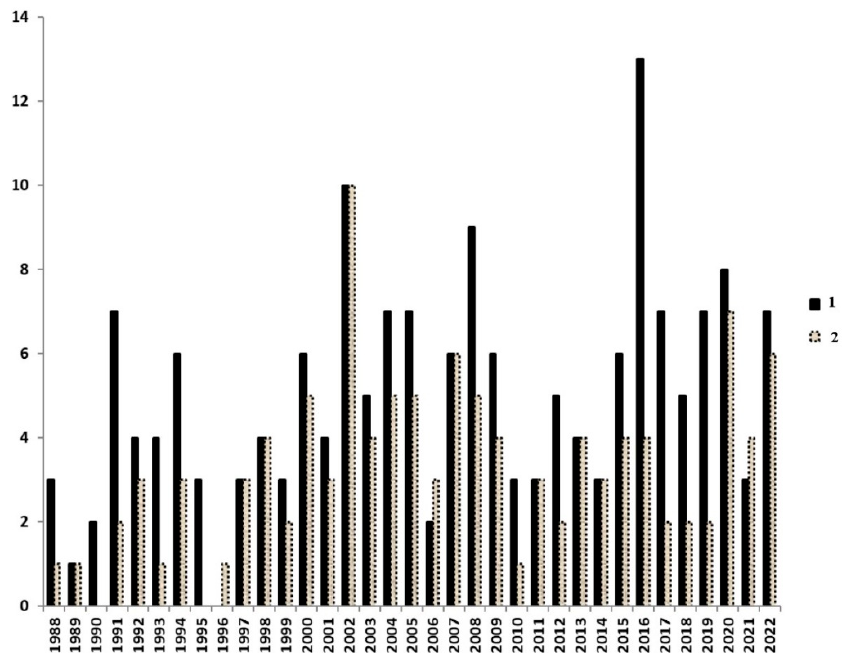
Figure 1. The number of patents and patent applications filed in the US in 1988–2022 according to the US ‐ PGPUB, USPAT, USOCR databases. Search by combinations of search words 1—“gold AND bioleaching” and 2—“nickel AND bioleaching AND bacteria”.